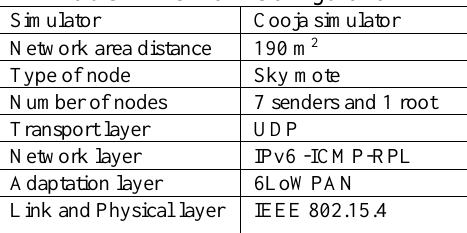
Table 1. Network